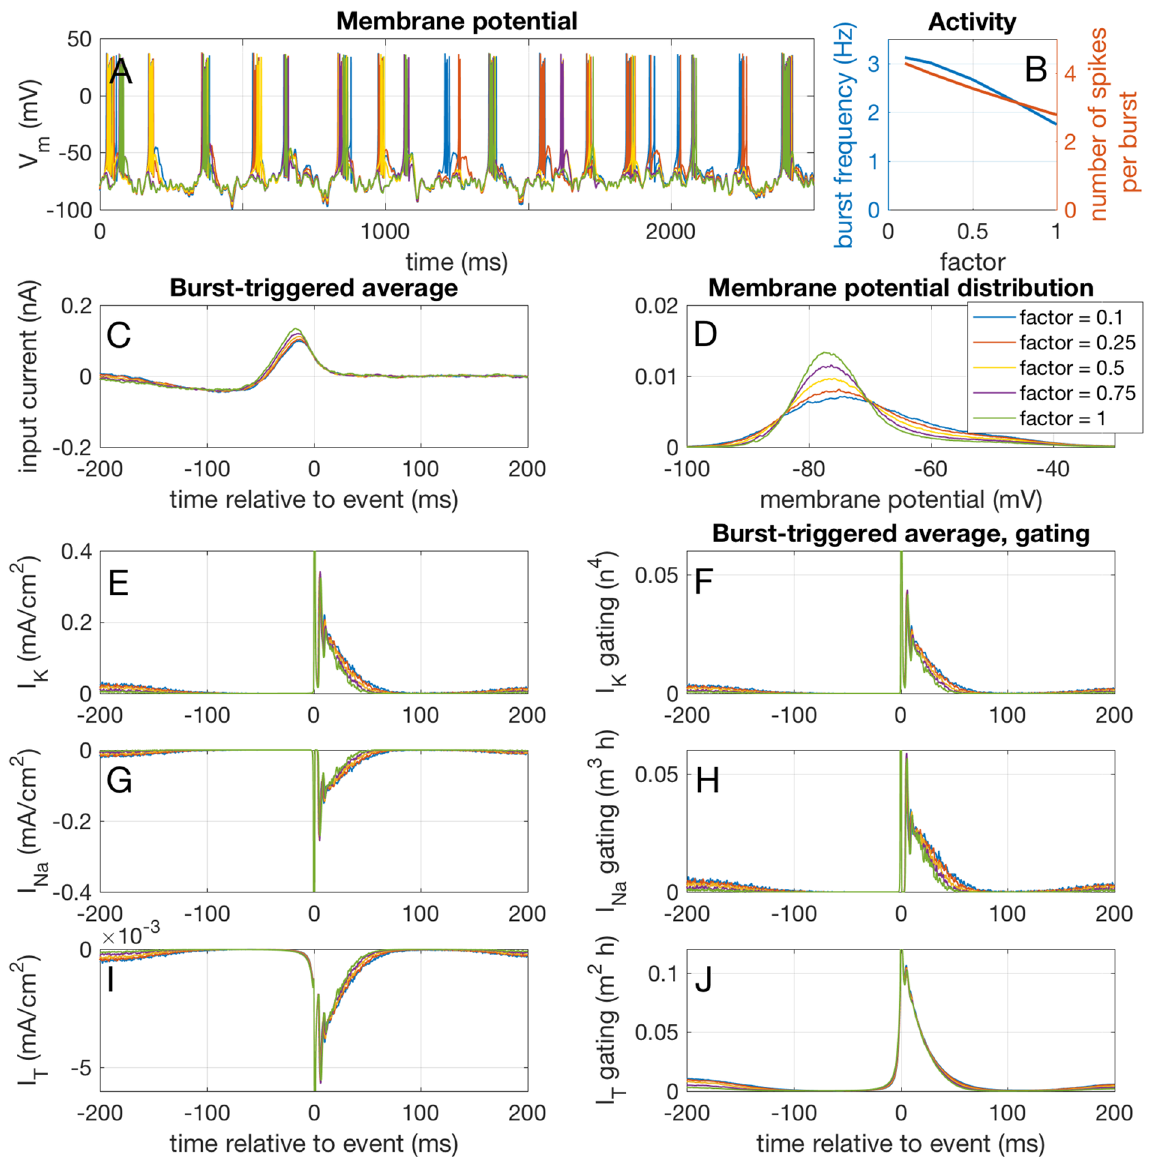
Fig 12. Effects of reducing the h-type current. The maximum conductance of the h-type current (cid:22) g pA) were reduced with the same factor f in the bursting regime. This resulted in a reduction of both the burst rate and the number of spikes per burst, as can be seen from the example traces in A and the event frequencies in B. Reducing the h-type current and mean input current resulted in a reduction of the width of the membrane potential distribution, while keeping the mean membrane potential at the same level (D). A stronger deviation from the mean input current was needed to trigger a burst (C). The burst-triggered potassium (E), sodium (G) and T-type (I) currents and gating (F, H and J respectively) show that this reduction in the width of the membrane potential distribution affects all three